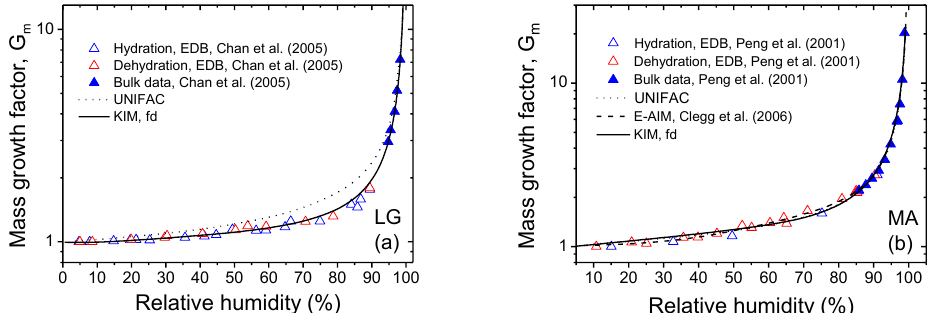
Figure 3: Mass growth factors observed for amorphous levoglucosan (LG) and malonic acid (MA) particles as a function of relative humidity. Data points: bulk experiments (filled triangles) and EDB experiments (open triangles) of hydration (blue) and dehydration (red) from (a) Chan et al. (2005) and (b) Peng et al. (2001). Model lines: KIM for fully dissolved (fd) particles (Eq. 31) – black solid; UNIFAC – black dotted; E-AIM, Clegg et al. (2006) – black dashed.